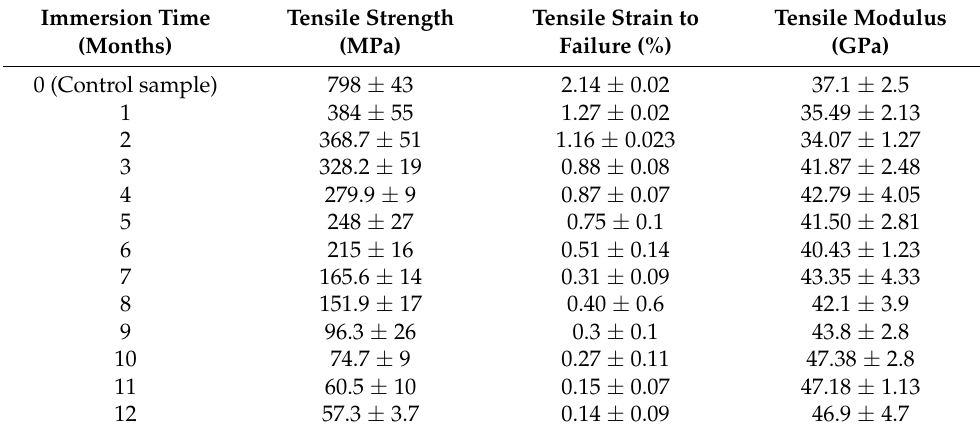
Table 4. Tensile properties of the specimen immersed in seawater at 90 ◦ C.